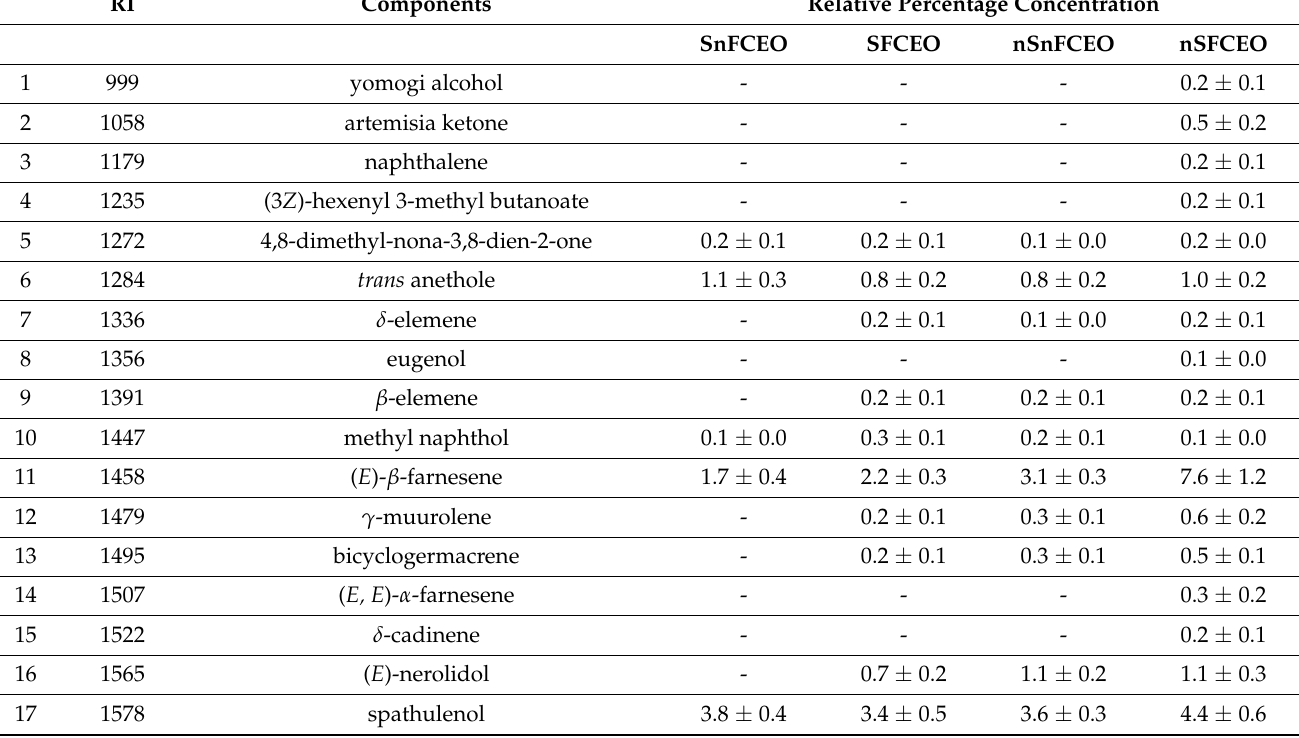
Table A1. Chamomile’s essential oils chemical composition under different treatments. SnFCEO: Shade without Fertilizer Chamomile Essential Oil, SFCEO: Shade with Fertilizer Chamomile Essential Oil, nSnFCEO: without Shade without Fertilizer Chamomile Essential Oil, nSFCEO: without Shade with Fertilizer Chamomile Essential Oil. Components are listed in order of elution from an TG-5MS column. Retention indices (RI), relative to n -alkanes, are listed alongside published values (Pub. RI from Adams 2007). Mean ± SD ( n =